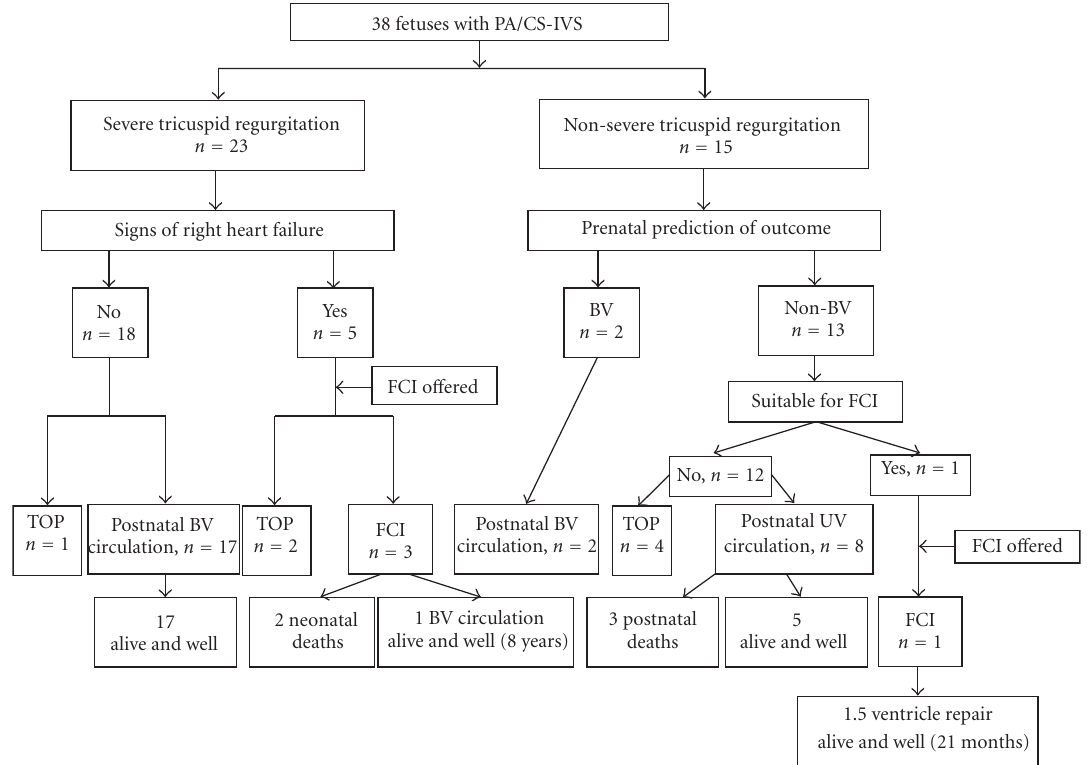
Figure 4: Flow chart showing the distribution of fetuses with pulmonary atresia/critical stenosis with intact ventricular septum (PA/CS- IVS) according to the process of selection for fetal cardiac intervention (FCI). BV, biventricular; UV, univentricular; TOP, termination of